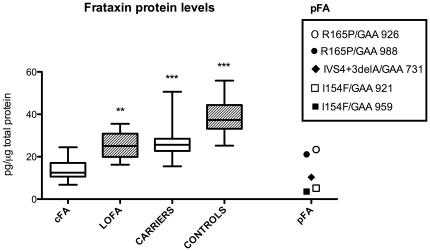
Frataxin protein levels in PMBCs.Box and wiskers plot (min to max) of frataxin levels in cFA (n = 24), LOFA (n = 5), carriers (n = 33), controls (n = 29), and pFA (n = 5). Statistical significance is indicated after comparison to cFA (**p>0.01, ***p<0.001).